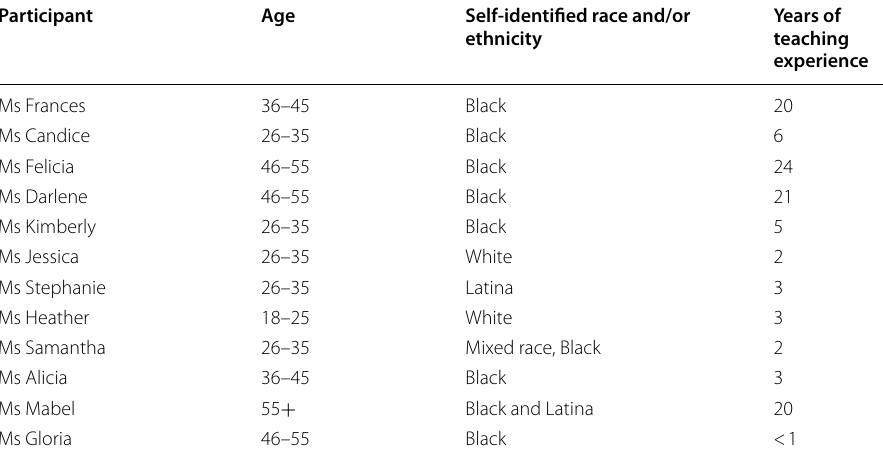
Table 2 Characteristics of